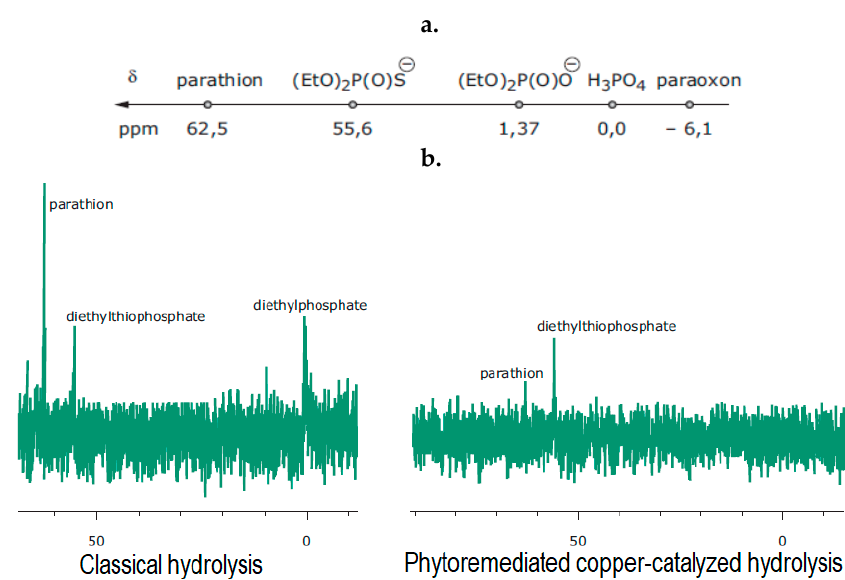
Figure 2. ( a ) The 31 P NMR chemical shift of the phosphorylated species and ( b ) the 31 P NMR study of the hydrolysis of parathion with commercially available Cu 2+ species (on the left) and the Eco-Cu prepared from the plant Bacopa monnieri after the rhizofiltration of copper(II) (on the right).